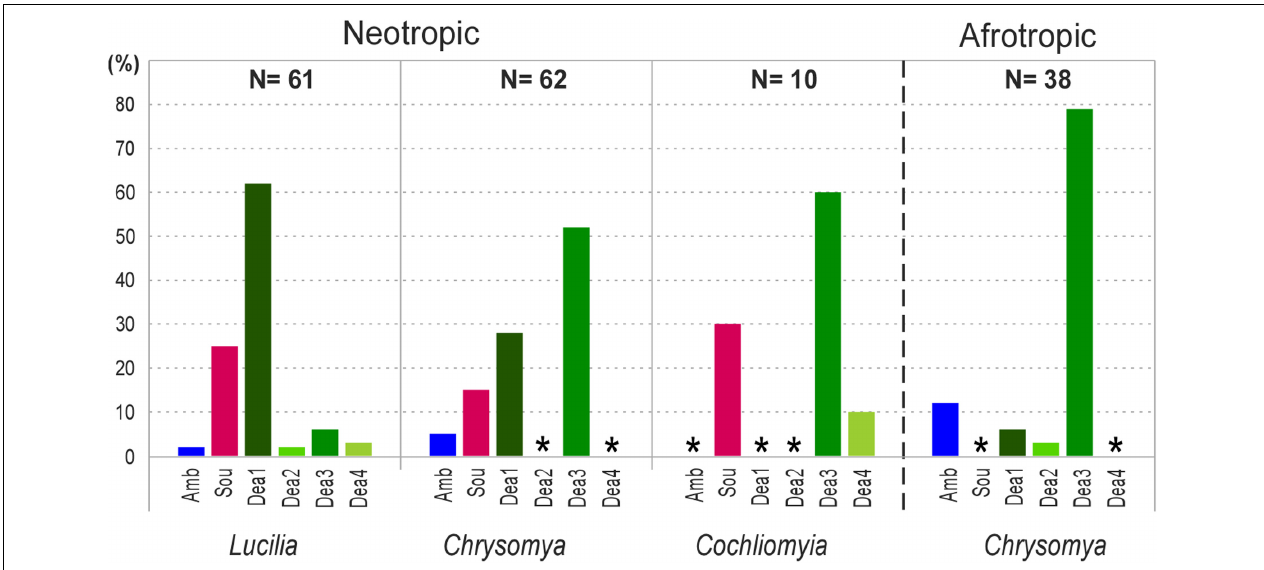
FIGURE 7 | Infection rates and geographical distribution of Angomonas species and genotypes in blowflies from the Afrotropic and Neotropic. A. ambiguus (Amb), A. desouzai (Sou), and A. deanei (Dea1–Dea4 genotypes) detected in calliphorids of the genera Chrysomya, Lucilia , and Cochliomyia . N = number of infected blowflies. The asterisk indicates absence. Angomonas was not detected in Lucilia from the Afrotropic. Detailed data from each fly genera are shown in Table 1 , and result obtained from each fly culture and gut sample are shown in Supplementary Table 1.